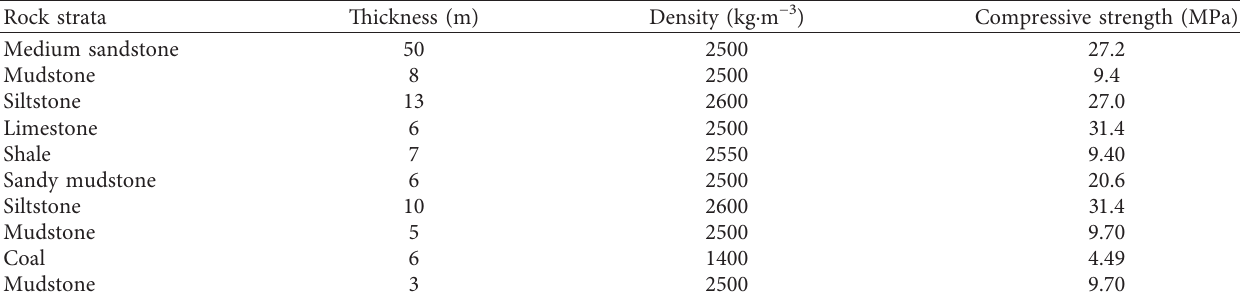
Table 1: Thickness and physical or mechanical properties of rock strata.